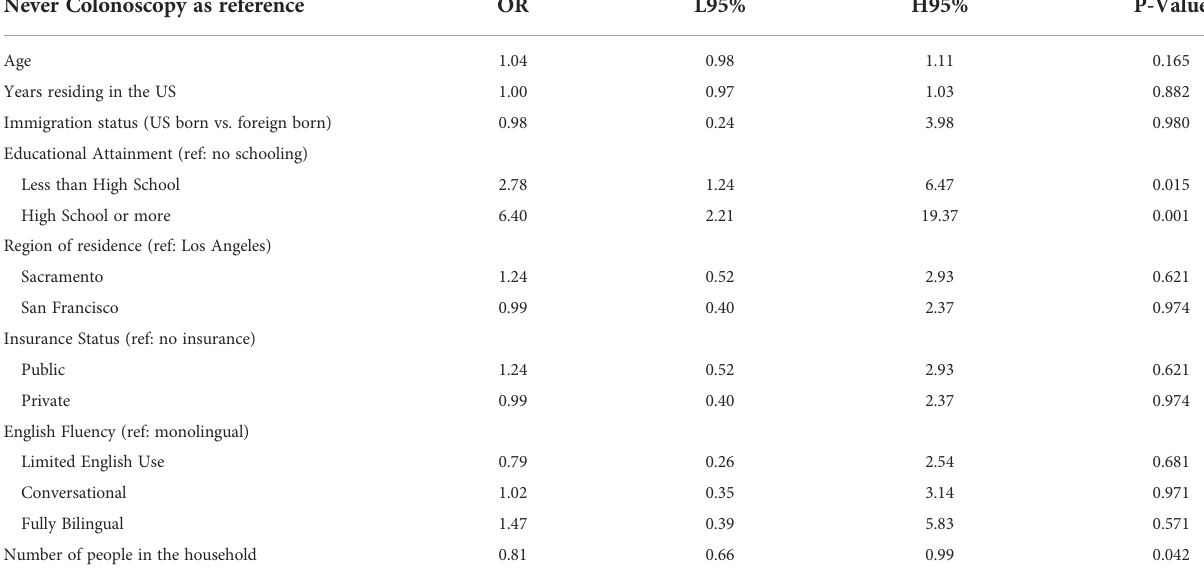
TABLE 6 Multivariate logistic regression model testing the association between colorectal screening behavior and demographic factors among ‘ Tu Historia Cuenta ’ participants ages 50+ (N=240, 24 excluded from 264 due to missing data). Never Colonoscopy as reference OR L95% H95% P-Value 1.04 0.98